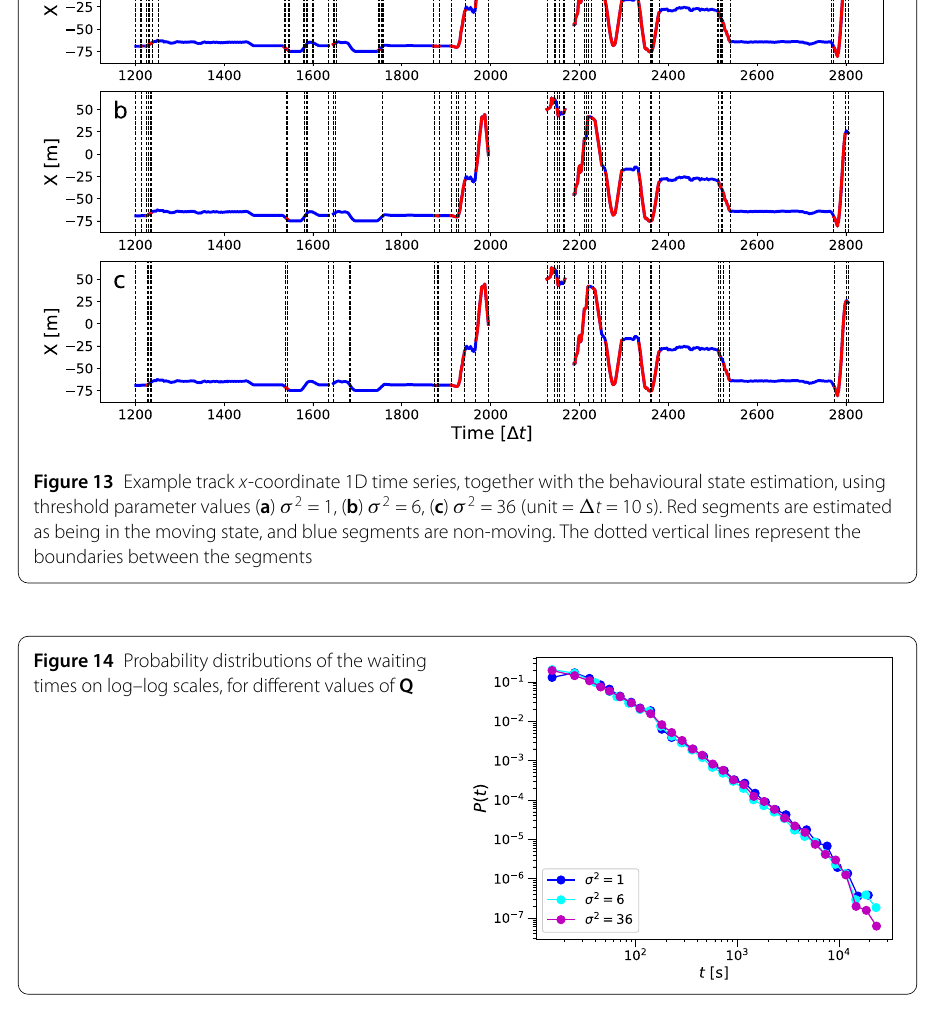
Table 3 Overview of fitting results using different values for Q . Shown are the MLEs for the truncated power law, which provided the best model for the data, according to model selection based on Akaike weights Parameter value t max